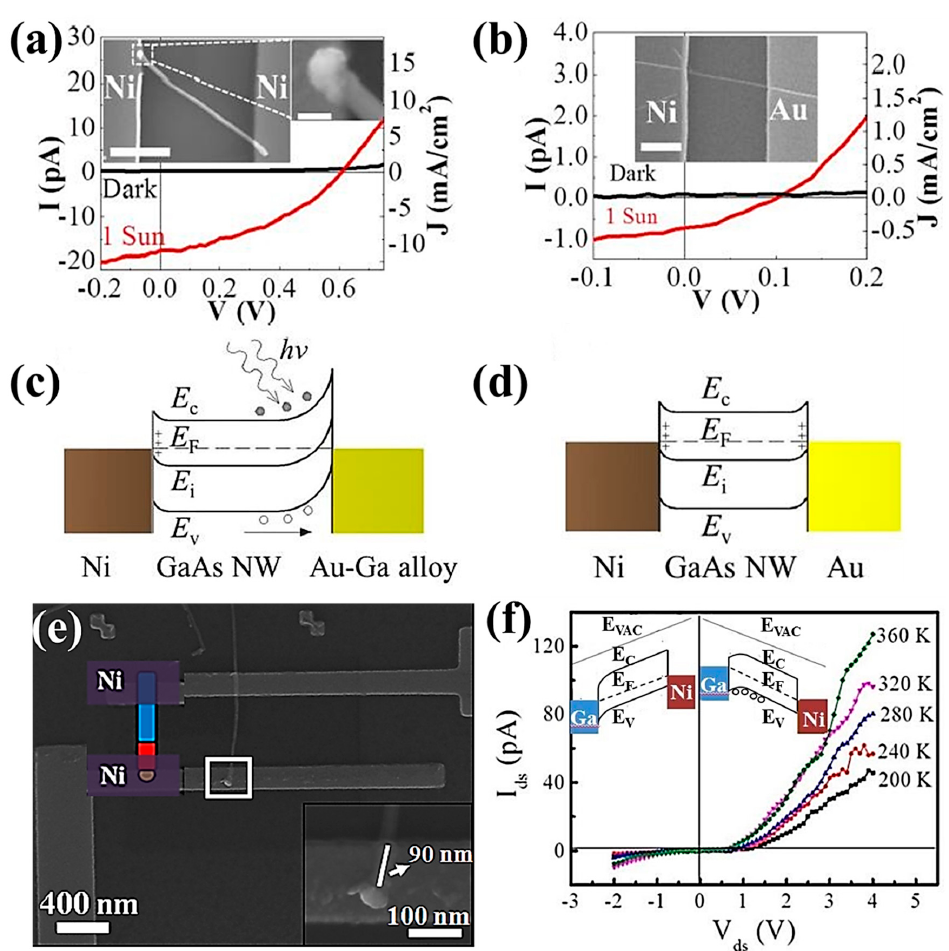
Figure 4. Schottky barriers of the catalyst/NW interface. ( a , c ) Typical I–V characteristics, scanning electron microscope (SEM) image and energy band diagram of the single GaAs NW photovoltaic device with Ni and the Au–Ga alloy tip. ( b , d ) I–V characteristics, SEM image and energy band diagram of the NW photovoltaic device with deposited Ni and Au. ( e , f ) device SEM and I–V curves of the Ga/GaAs interface. Adapted with permission from [58,122].